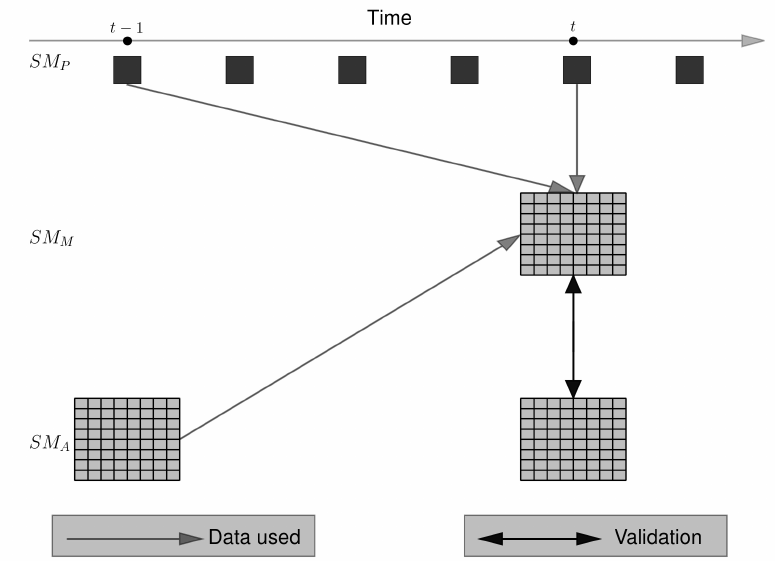
Figure 8. Validation strategy for the MAPSM model. Subscript A , P and M stands for the active microwave, passive microwave and MAPSM